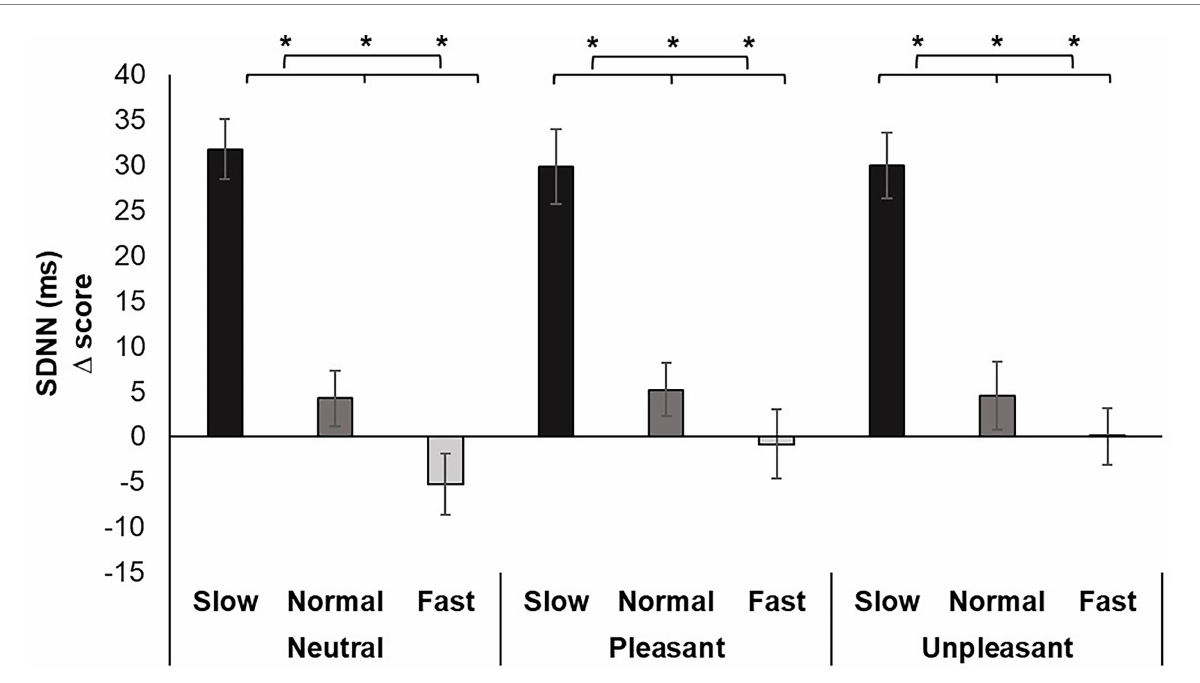
FIGURE 4 Mean SDNN change scores for each breathing frequency condition and image valence in milliseconds (ms). Greater values indicate increases in HRV. Error bars represent +1 SE from the mean. Asterisks represent significant differences ( p < 0.05).